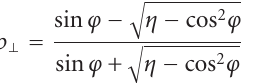
plane) polarization,